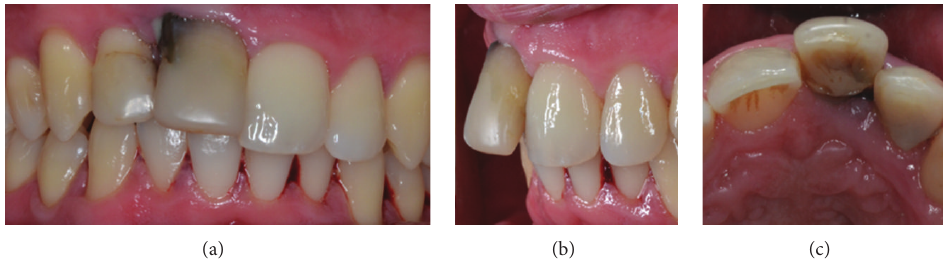
Figure 5: Clinical images after 18 years since the diagnosis. Notice a progressive pathological migration in buccal direction.